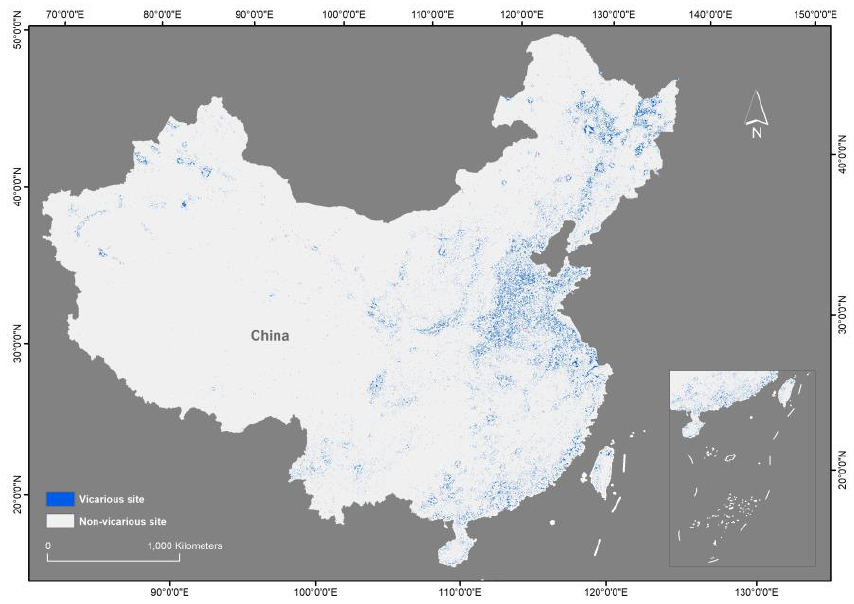
Figure 2. Distribution of the vicarious site.